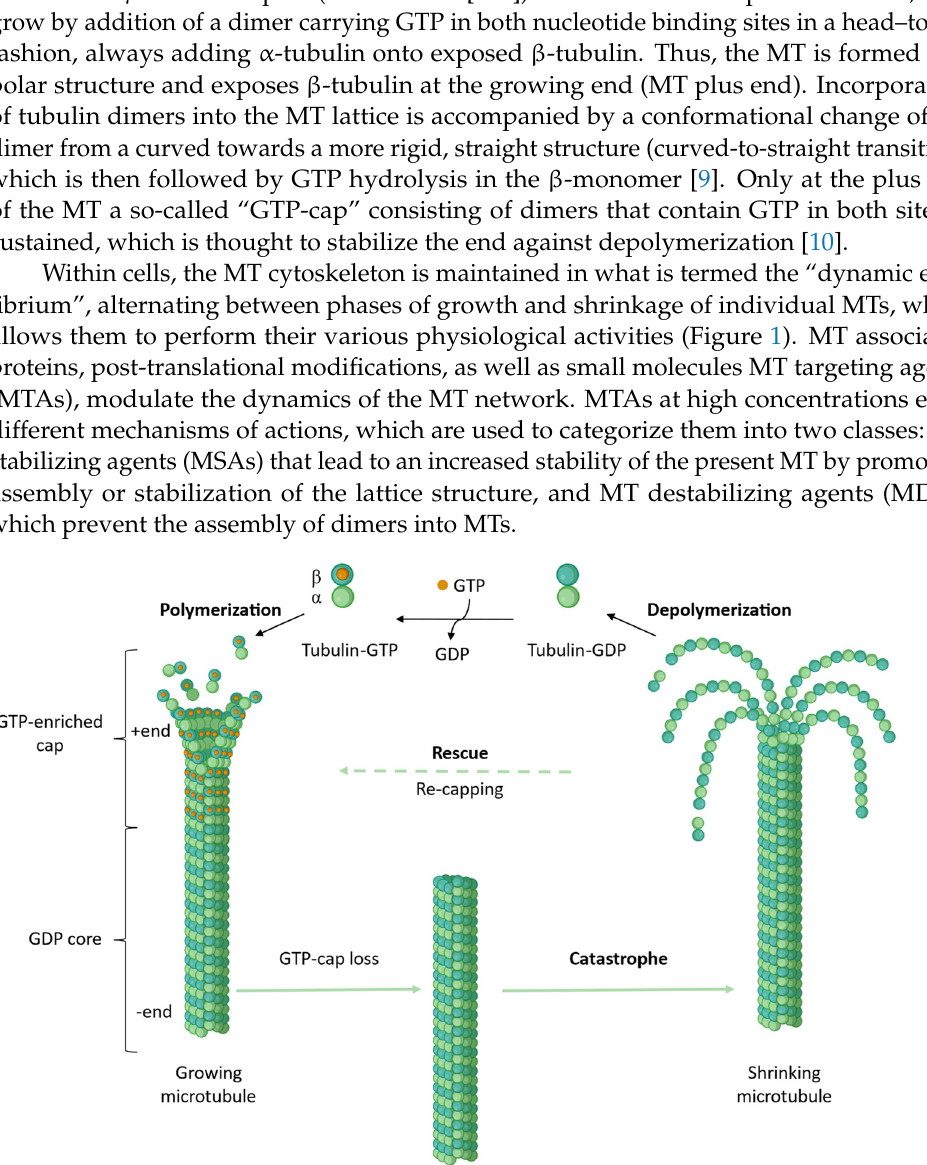
Figure 1. Microtubule dynamic equilibrium. MTs are constantly alternating between growth and shrinkage phases, while the − end of the MT is displaying some dynamics the overall stability is governed by quicker processes at the MT +end. Growth of an MT is facilitated by incorporation of two GTP containing tubulin dimers onto the +tip, followed by lattice incorporation, which leads to subsequent GTP hydrolysis. On the top of the growing MT a “GTP-cap” consisting of GTP-dimers stabilizes the structure. Exchange of this capping dimers against GDP tubulin leads to depolymerization. Adapted from “Microtubule (polymerizing and depolymerizing)” by BioRender.com (accessed on 15 December